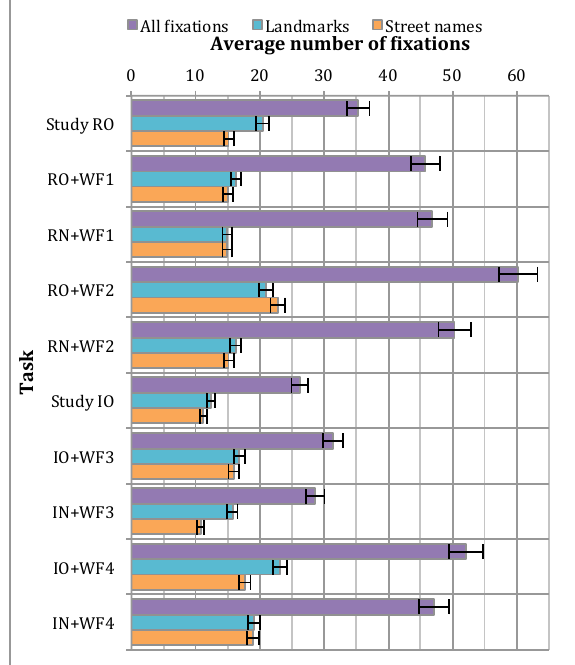
Figure 8. Fixations on landmarks and street